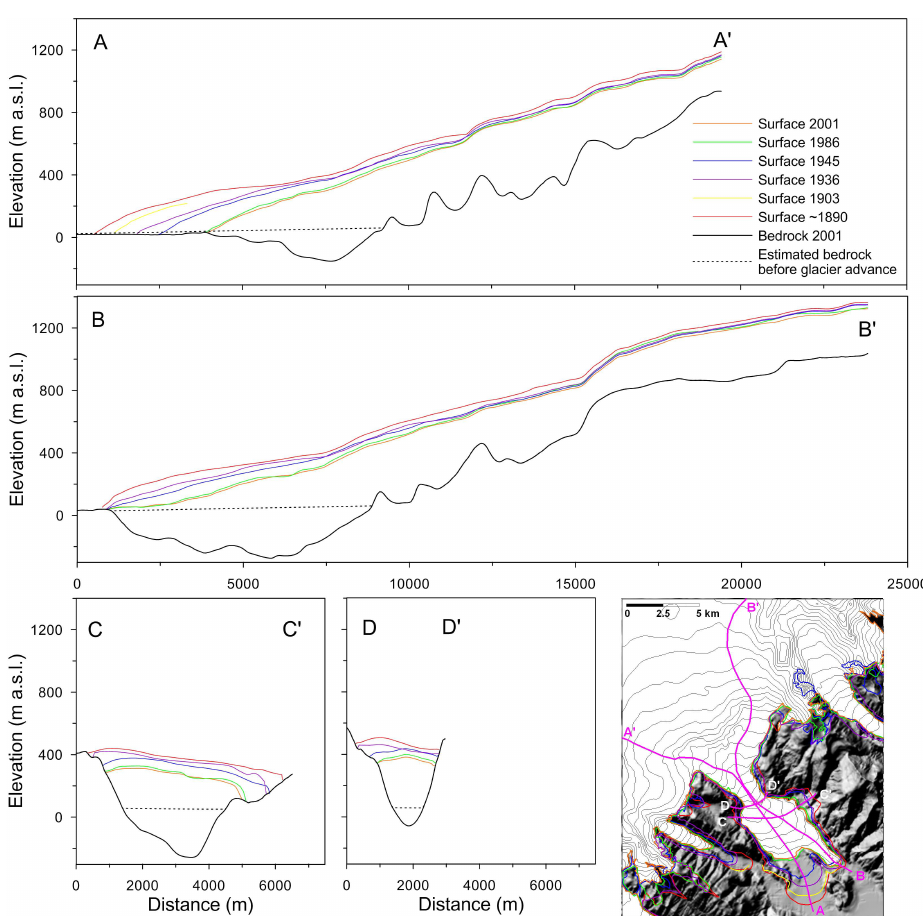
Fig. 4. Two longitudinal profiles and two cross sections showing the thickness and the location of the terminus at different times. The map shows the location of the sections and the terminus position at the different times.